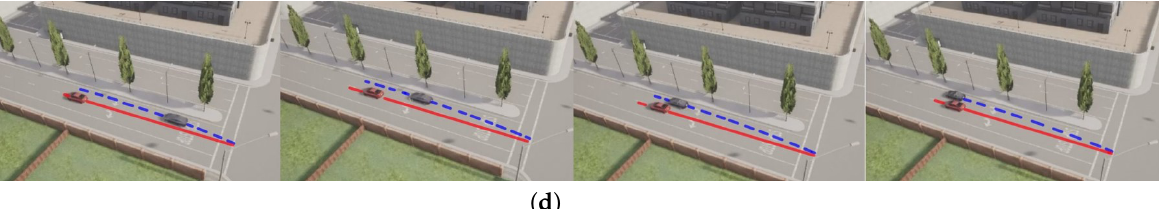
Figure 8. The agent performs using DQN model at 1400, 5000, 7000, and 8000 training episodes. episodes.